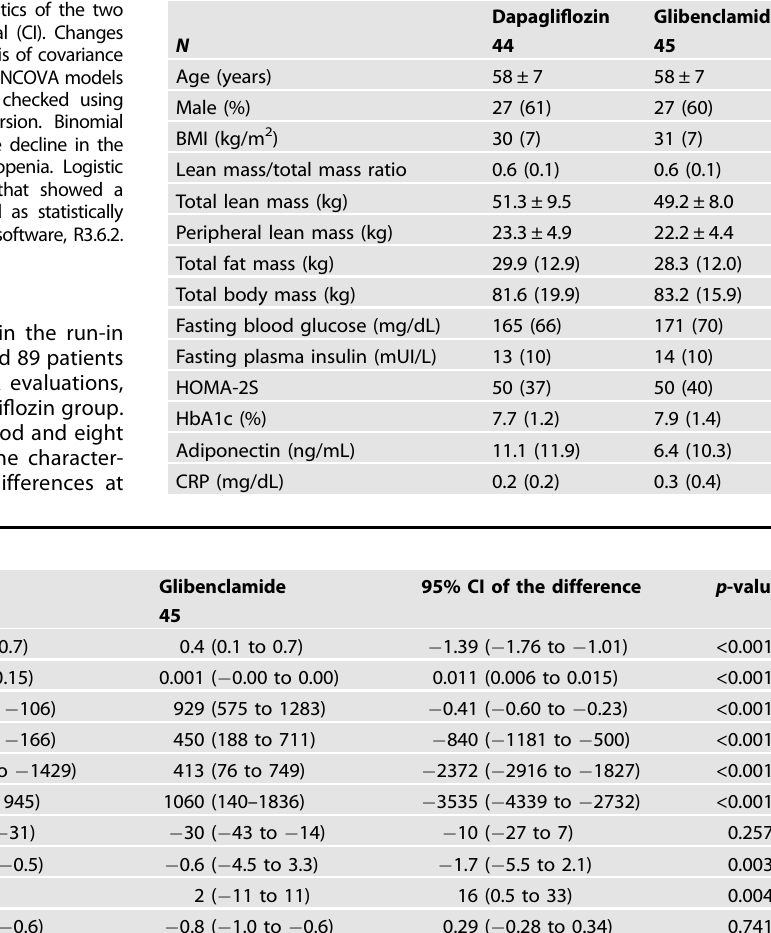
Table 1. Characteristics of the two groups at baseline.